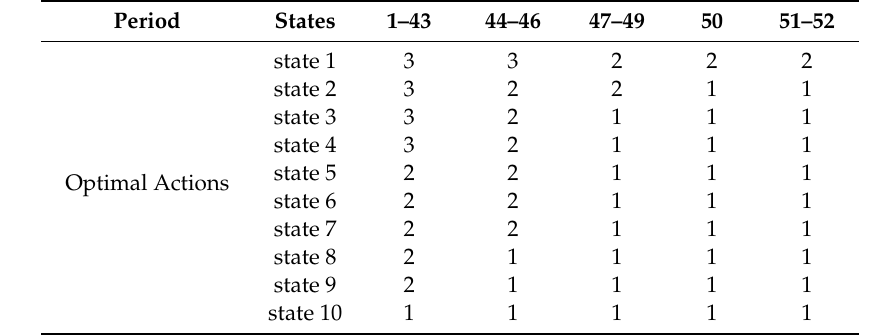
Table 6. Optimal